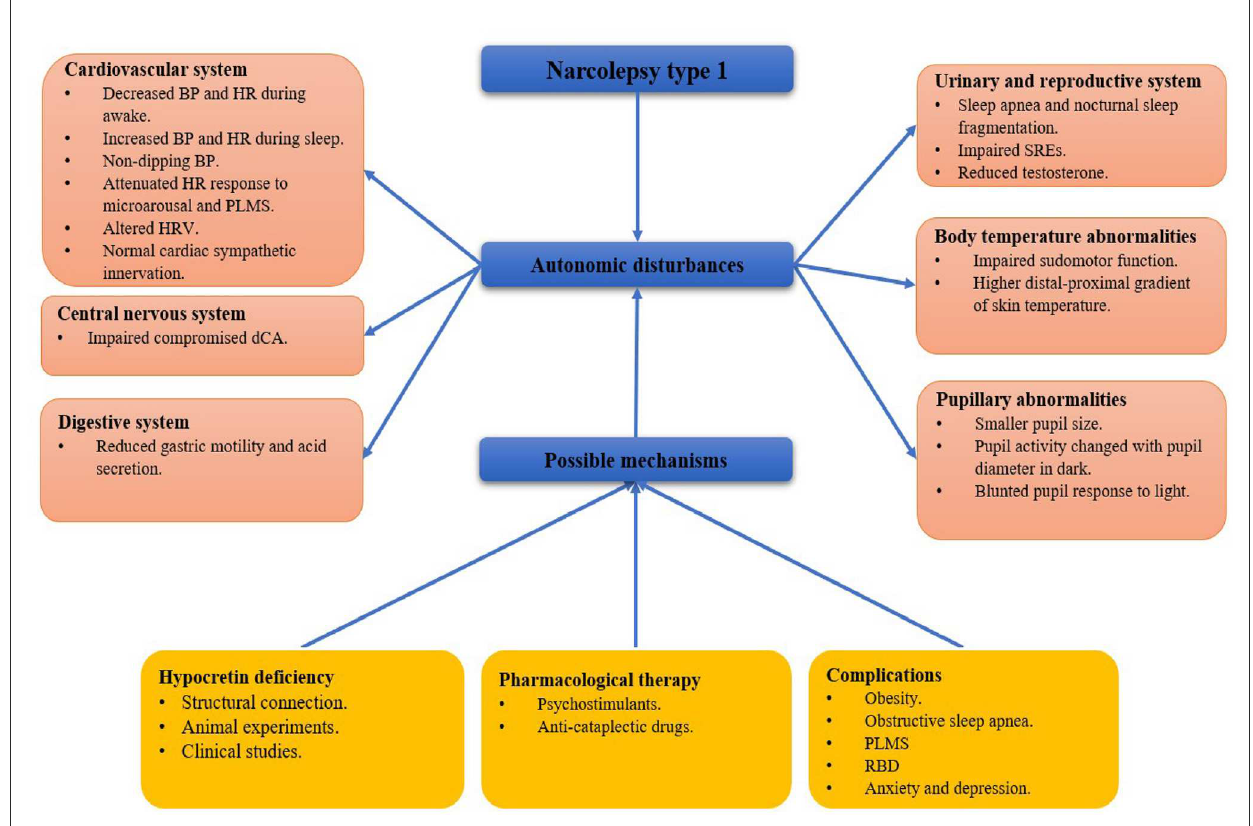
FIGURE1 A framework of autonomic disturbances and possible mechanisms in narcolepsy type 1. BP, blood pressure; HR, heart rate; PLMS, period limb movements during sleep; HRV, heart rate variability; dCA, dynamic cerebral autoregulation; SRE, sleep-related erection; RBD: rapid eye movement sleep behavior